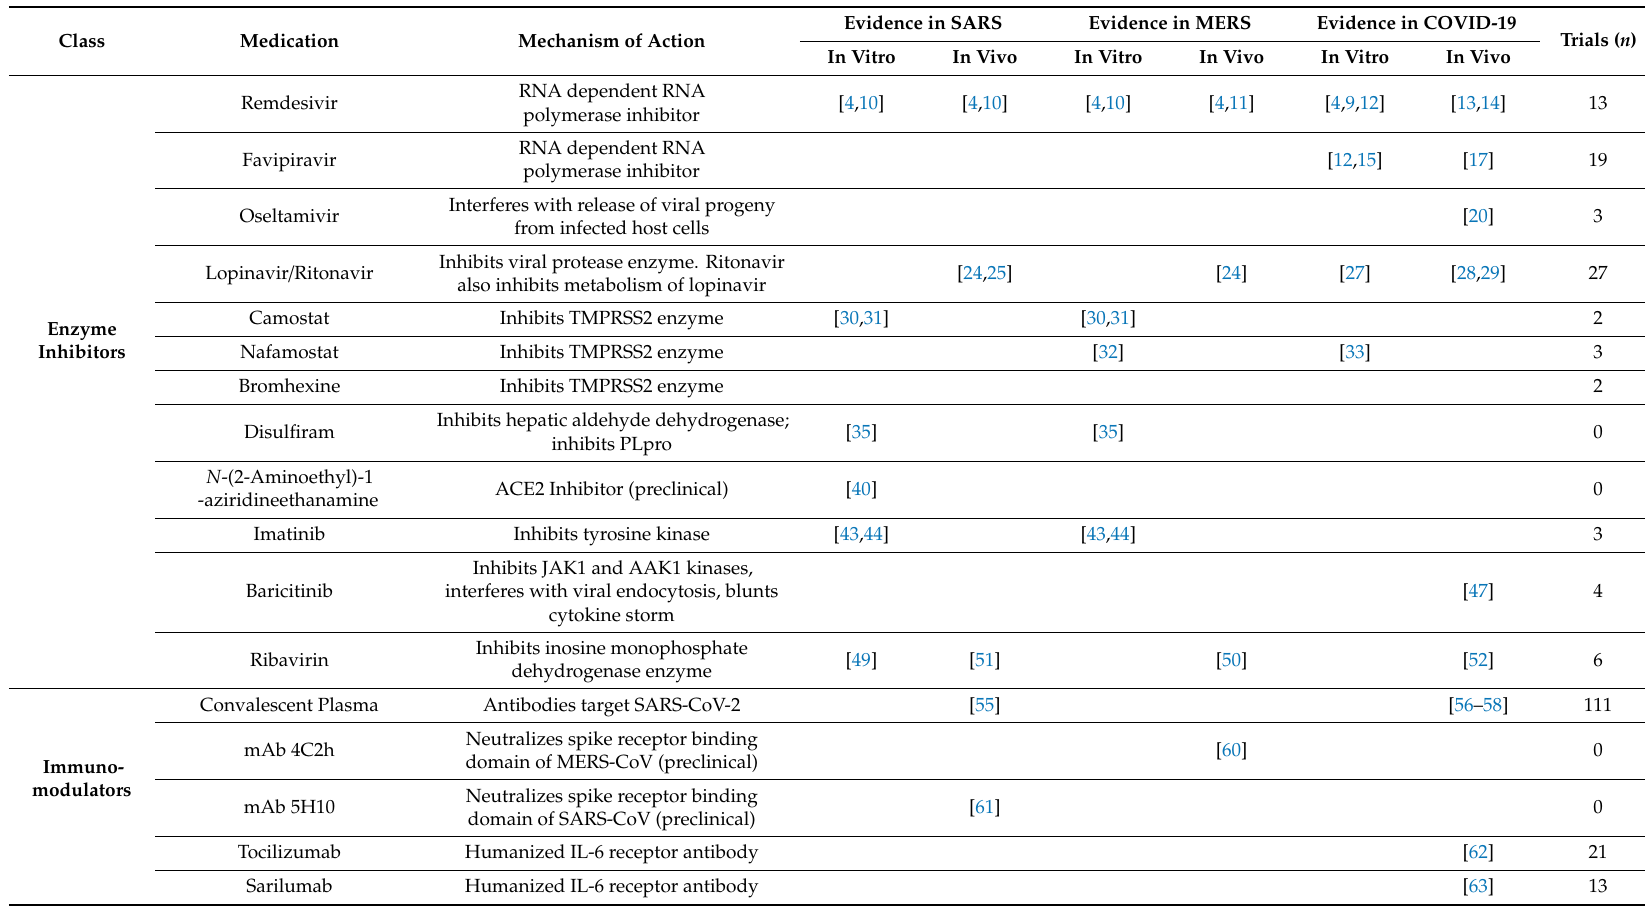
Table 1. Summary of pharmaceuticals with potential for repurposing for treatment of COVID-19 based on evidence in SARS or MERS. This table summarizes the class of each medication reviewed and briefly indicates the relevant mechanism of action. Numbers in the three columns “Evidence in SARS,” “Evidence in MERS,” and “Evidence in COVID-19” reference key citations that describe studies of each medication in the relevant disease (SARS, MERS, or COVID-19). The rightmost column, “Trials”, describes the number (n) of trials registered for each drug in the Cochrane Controlled Register of Trials as of 24 June